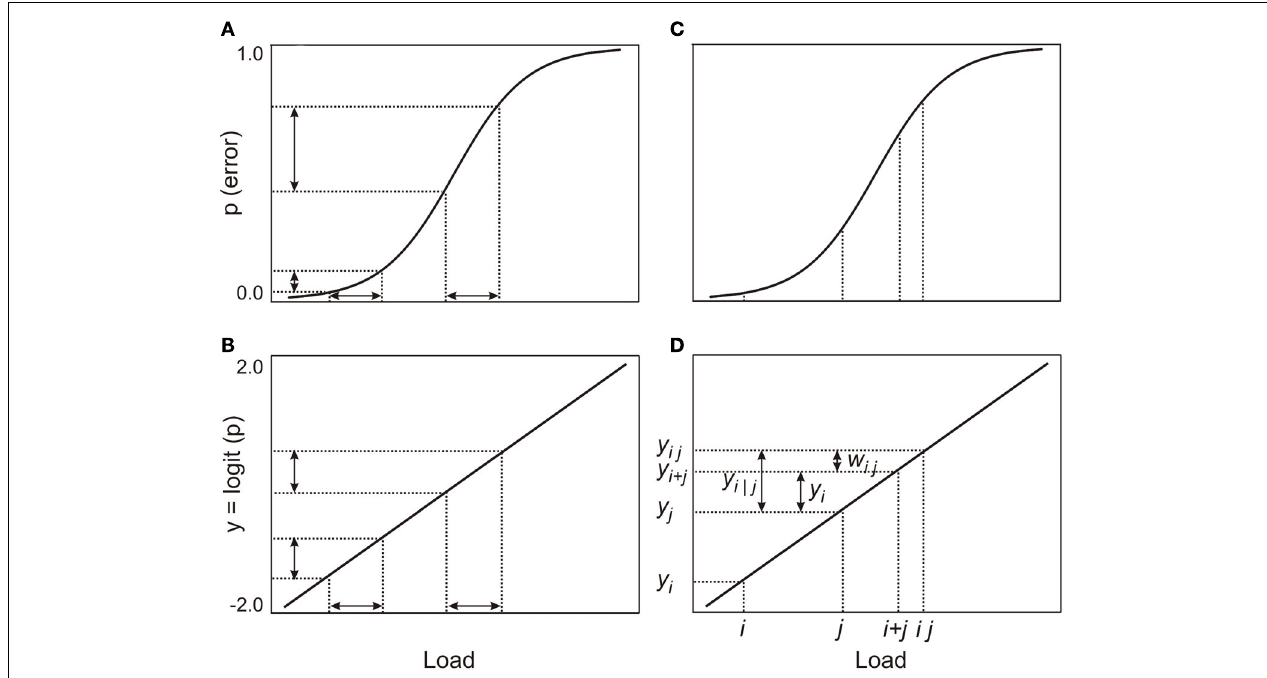
FIGURE 1 | Illustration of the model: (A,B) show the effects of the logit transformation; the transformed differences in probabilities are now